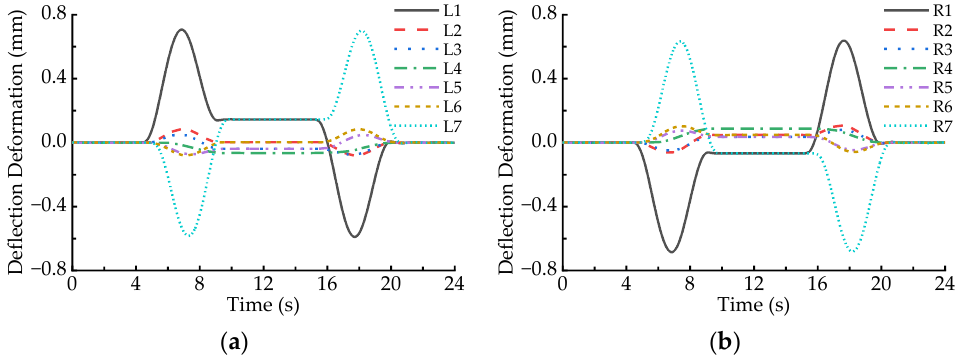
Figure 8. Deflection deformation of the LMs passing through the 650 m radius curve at the speed of 93 km/h: ( a ) L1~L7; ( b ) R1~R7.